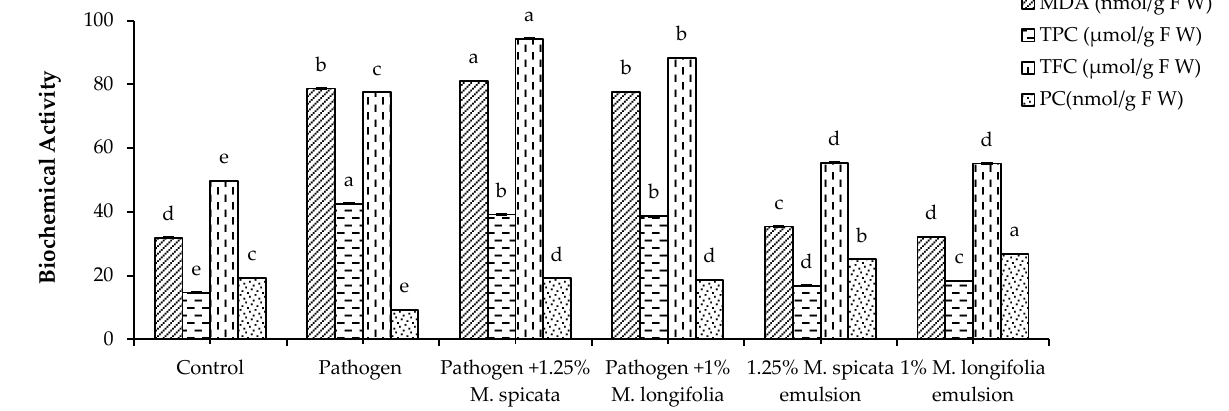
Figure 7. Effects of highest concentrations of M. spicata and M. longifolia EOs on MDA, TPC, TFC,